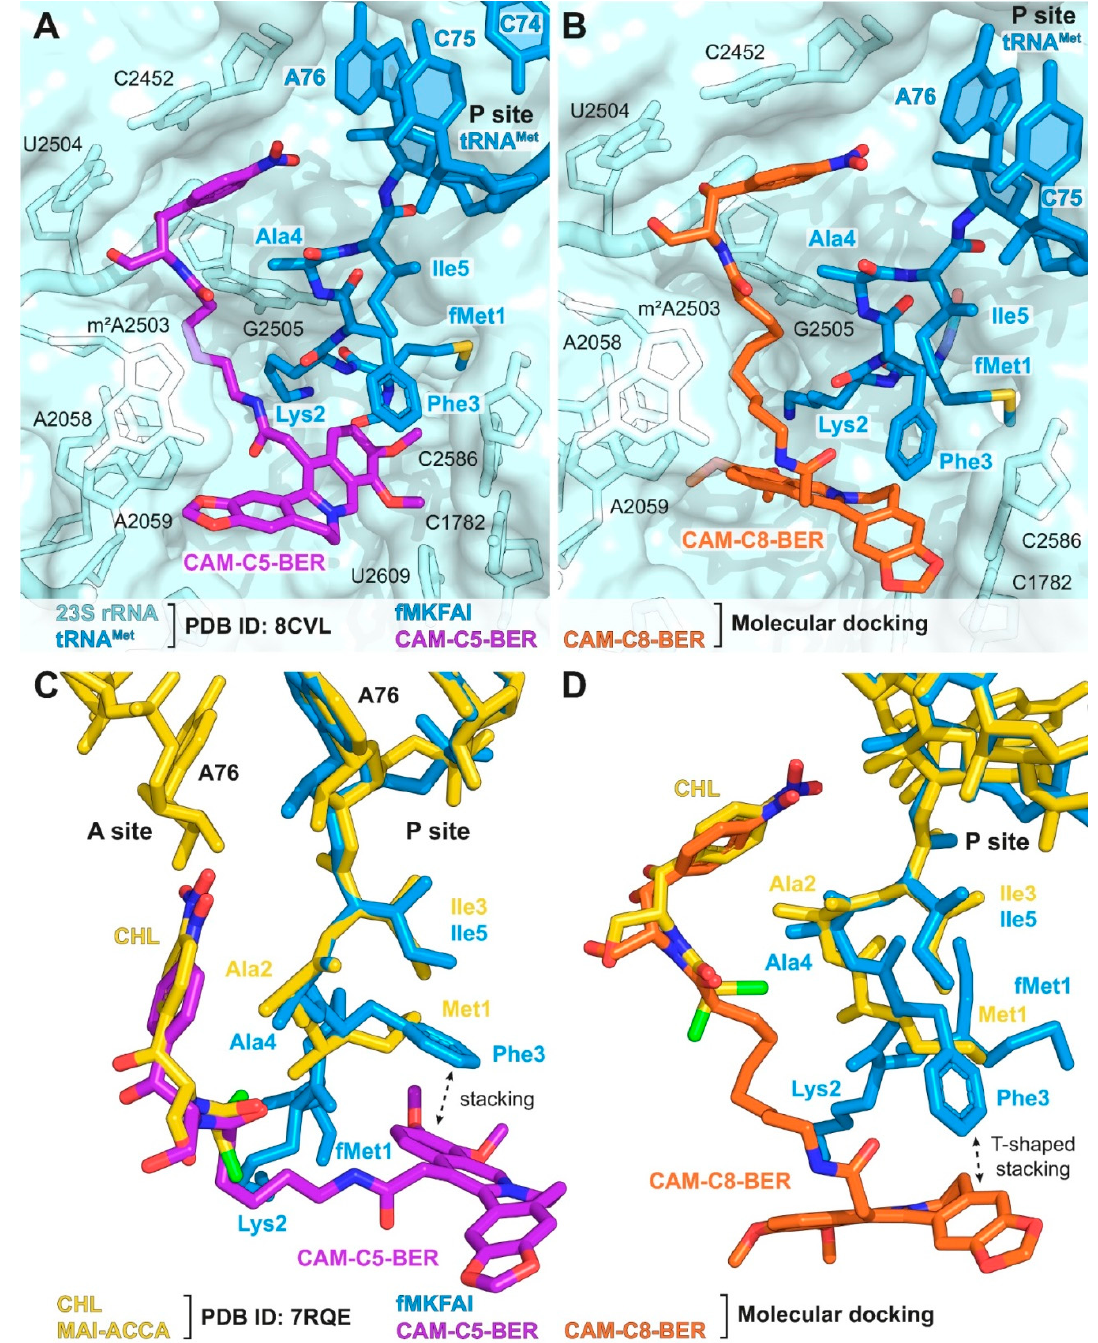
Figure 4. Structures of complexes of CAM-C5-BER and CAM-C8-BER with the T. thermophilus ribosome obtained by molecular docking. ( A,B ) Structures of CAM-C5-BER ( A , purple), CAM-C8-BER ( B , orange), and fMKFAI-NH-tRNA Met (blue) docked into the crystal structure of T. thermophilus ribosome (PDB ID: 8CVL [76], light blue). ( C,D ) Superposition of the structures of CAM-C5-BER ( C , purple) and CAM-C8-BER ( D , orange) in complex with T. thermophilus ribosome carrying fMKFAI-NH-tRNA Met (blue) obtained by molecular docking with the previously reported crystal structure of CHL (yellow) and P-site MAI-ACCA (yellow) in complex with T. thermophilus ribosome (PDB ID: 7RQE [16]). E. coli numbering of nucleotides is presented.